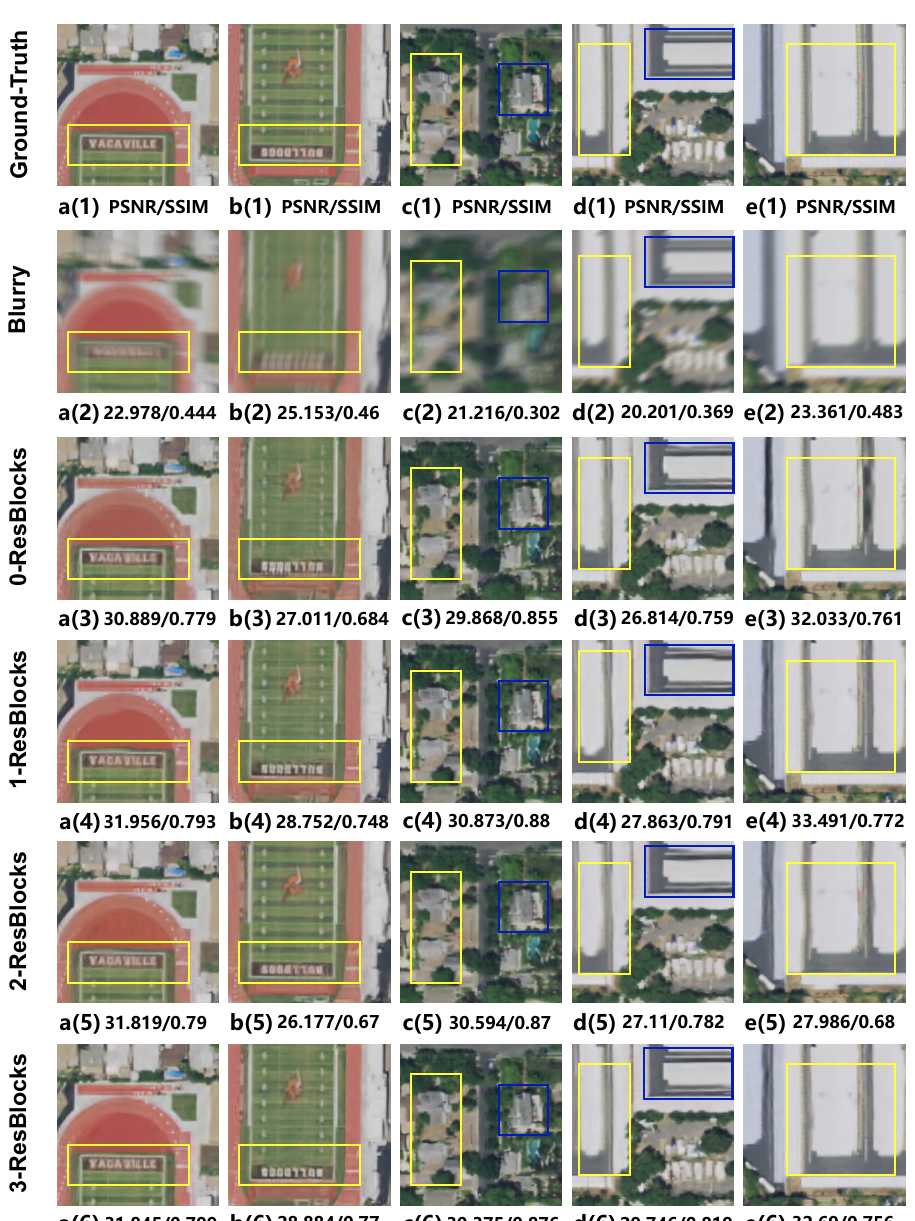
Figure 17. Visual comparison of images restored by Ref-MFFDN with different layers of ResBlocks added in